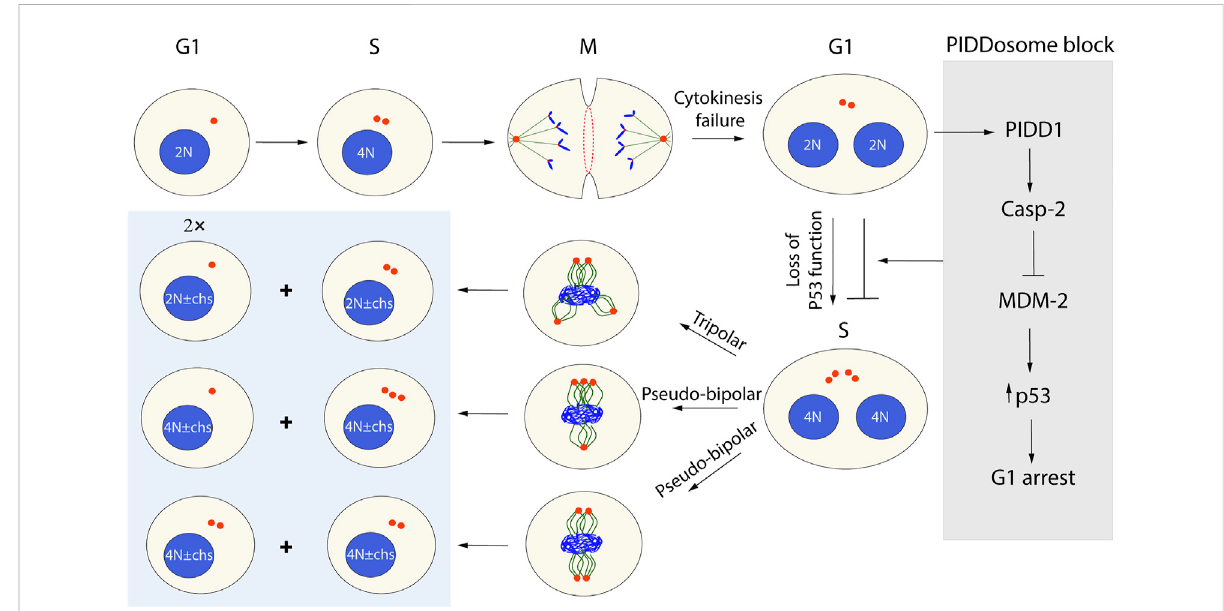
FIGURE 4 Possible outcomes of cytokinesis failure in the next cell cycle round. Cells that failed cytokinesis because of different abnormalities become tetraploid with supernumerary centrosomes (two mature centrosomes). In the G1 phase, the presence of more than one mature centrosome will activatePIDD1 andtriggerPIDDosome-induced cellcyclearrest ofnormal cells.However,someviralinfectionsandp53 mutations allow thecellsto bypassthePIDDosomeblock(graybox)andproceedthroughthecellcycle.IntheMphase,suchcellsmaydieorformaheterogenousprogeny of tetraploids or aneuploids (blue box), depending on how the centrosomes will be